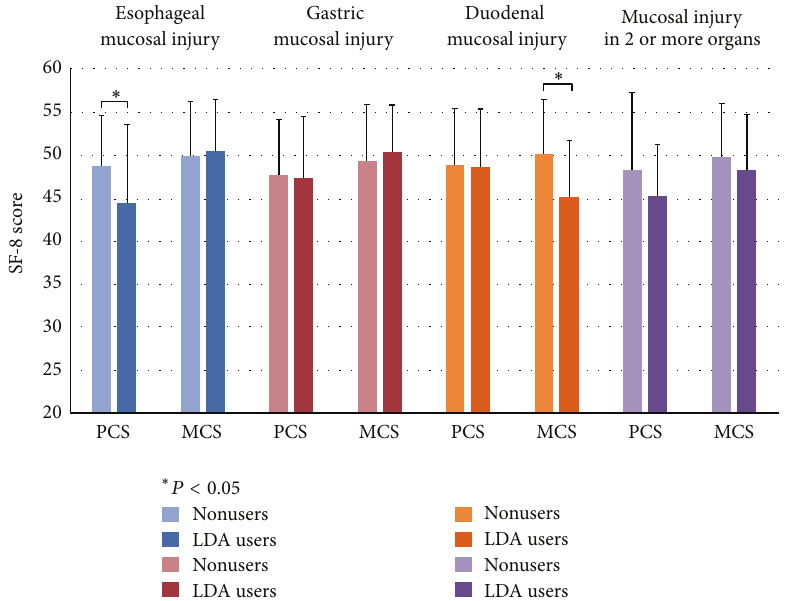
Figure 5: SF-8 score for mucosal injury in LDA users and nonusers. PCS and MCS among LDA users and nonusers were 44.5 ± 9.1 and 48.9±5.8 ( 𝑃 = 0.02 ) and 50.6±5.9 and 50.0±6.3 ( 𝑃 = 0.73 ) for EI; 47.4±7.1 and 47.7±6.4 ( 𝑃 = 0.75 ) and 50.5±5.4 and 49.5±6.6 ( 𝑃 = 0.27 ) for GI; 48.8 ± 6.7 and 49.0 ± 6.6 ( 𝑃 = 0.85 ) and 45.3 ± 6.6 and 50.3 ± 6.3 ( 𝑃 = 0.04 ) for DI; and 45.4 ± 9.1 and 48.3 ± 6.0 ( 𝑃 = 0.20 ) and 48.4 ± 6.3 and 49.8 ± 6.4 ( 𝑃 = 0.28 ) for mucosal injury in 2 or more organs. PCS = physical component score and MCS = mental component